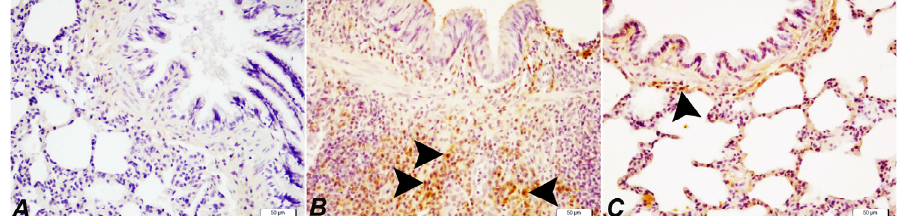
Figure 5. Immunohistochemical staining of COX-2 in experimental groups in lung tissue (×40), Bar:50 µm. Control group ( A ), negative COX-2 expression; DEN group ( B ), Intracytoplasmic COX- 2 expressions in lymphocytes and macrophages due to severe inflammatory reactions in the lung tissue (arrowhead); DEN + SOR group ( C ), COX-2 expression (arrowhead). Control: healthy group (no treatment), DEN: diethylnitrosamine group, DEN + SOR: DEN + 10 mg/kg sorafenib. Table 2. Scoring immunohistochemical results for lung